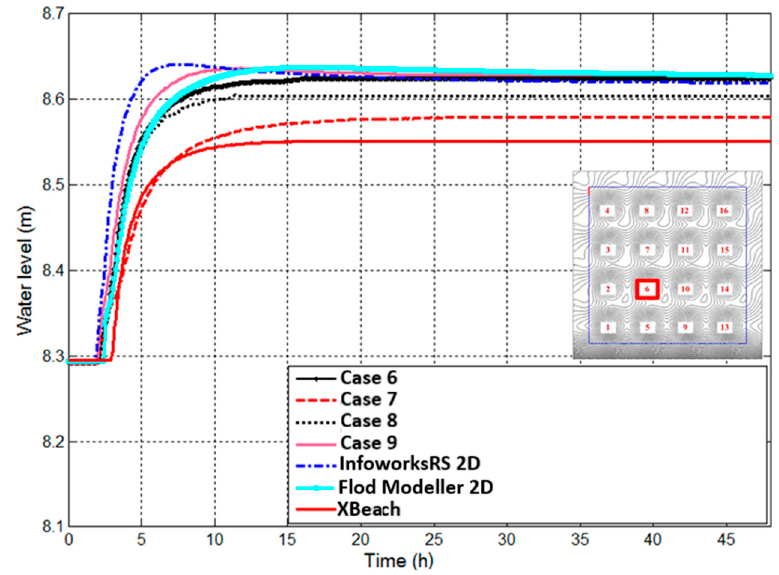
Figure 17. Filling of floodplain depressions: water level results for Depression 6.